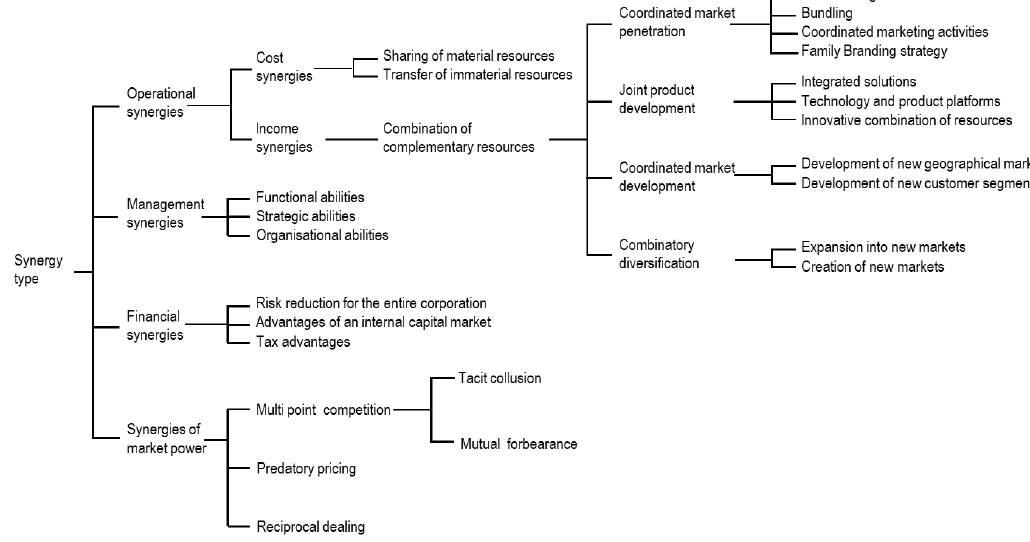
Figure 5. Classification and specification of synergies according to Müller-Stewens and Brauer. Source: Based on [10] (2009: p. 376),